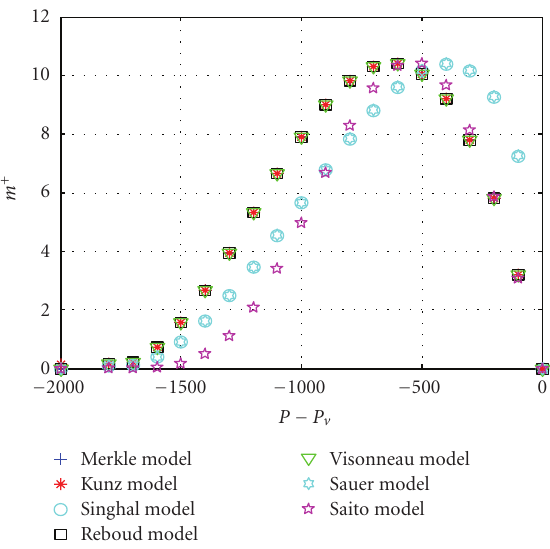
Figure 2: Source terms for the condensation